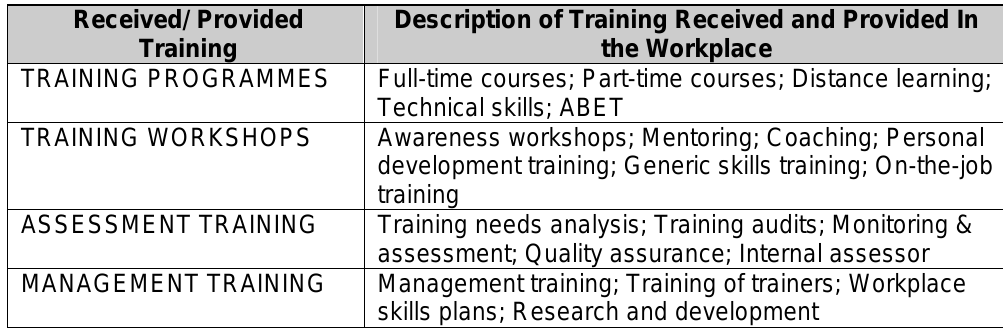
Table 2: Workplace training received and